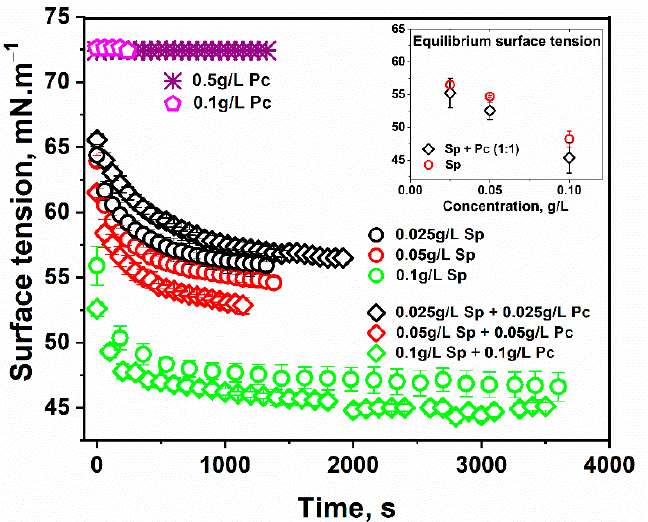
Figure 1. Surface tension of aqueous solutions containing Quillaja saponin-only, Apple pectin-only, and Quillaja saponin and Apple pectin 1:1 (g/L, by weight) mixtures, using Tensiometer K20, Krüss. The temperature was kept at 22 °C. Inset: Equilibrium surface tension values of Quillaja saponins (red symbols) and Quillaja saponin and Apple pectin mixture solutions (black symbols).